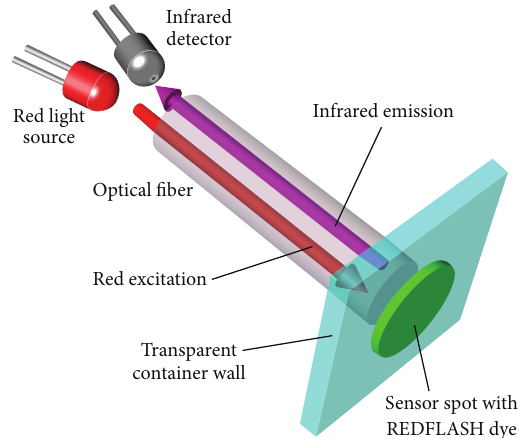
Figure 2: Optical sensor used to detect particles that react with the food products. (Source: optical sensors consulted in http://www